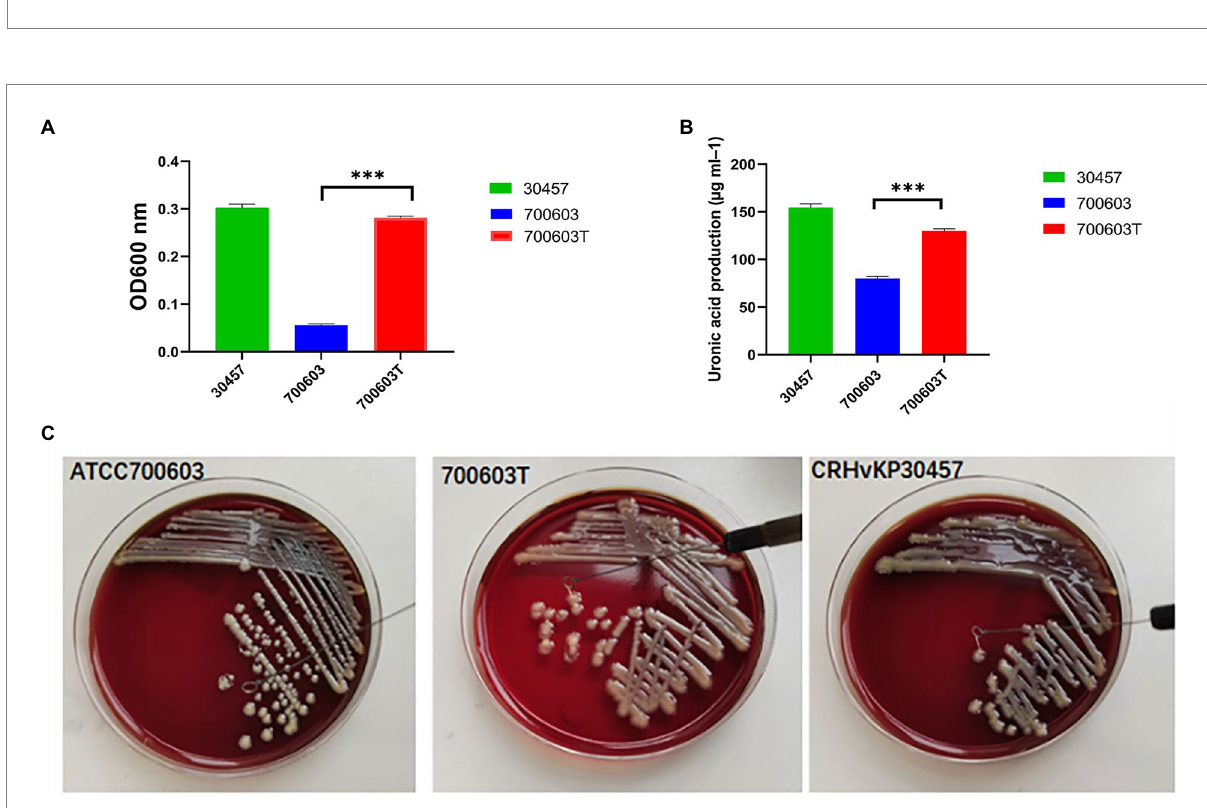
FIGURE 5 Mucoviscosity (A) , uronic acid production (B) , and string tests (C) of the 700,603 transformant strain.Two-way ANOVA tests were performed for statistical analysis. *** , p <